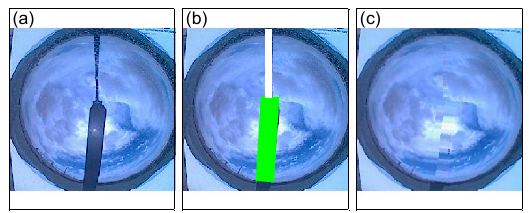
Figure 2. TSI image: ( a ) Raw image, ( b ) occlusion location, ( c ) occlusion recovery.